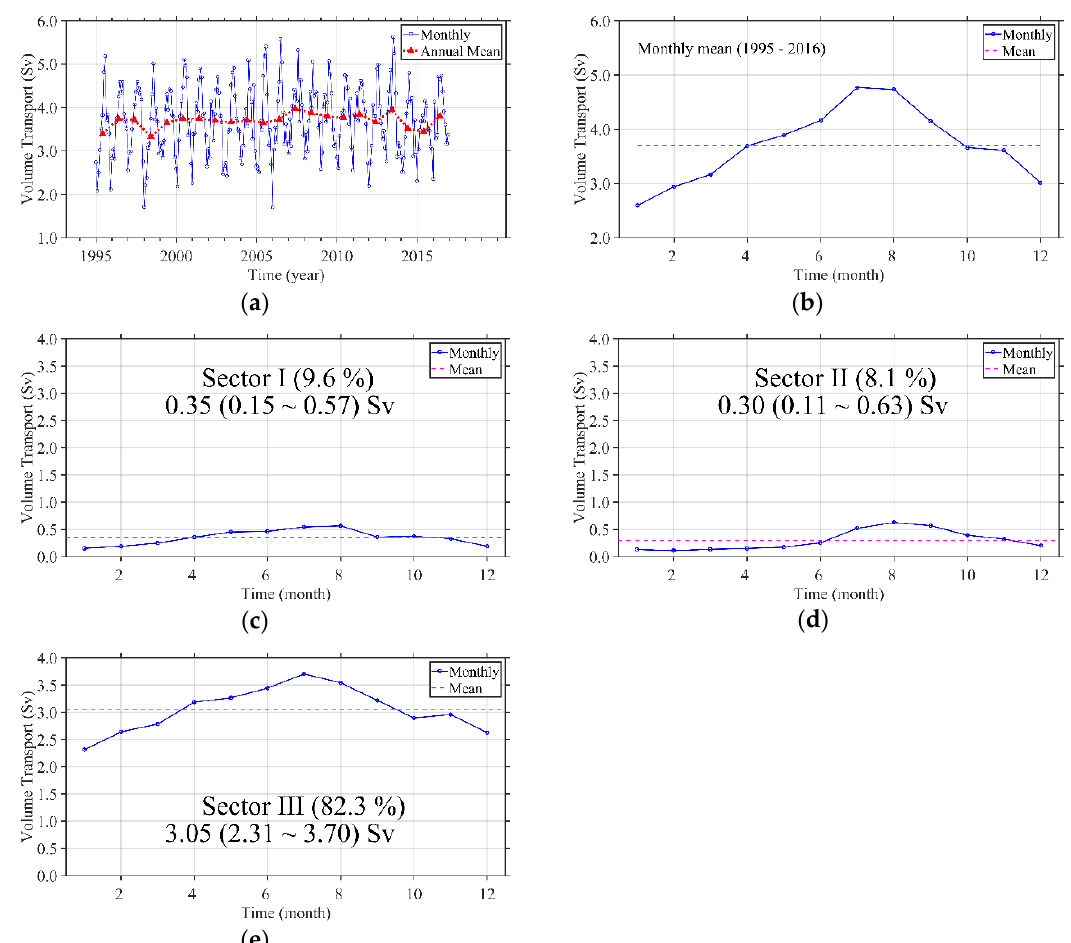
Figure 8. Annual distribution of volume transport into the study area from 1995 to 2016 ( a ). Monthly average distribution of volume transport ( b ). Monthly average distribution of volume transport for sector I ( c ), sector II ( d ), and sector III ( e ).